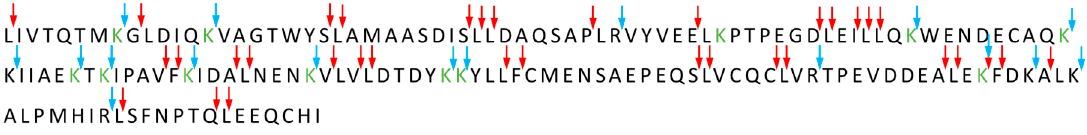
Figure 3. Predicted cleavage sites of pepsin at pH 1.3 (red arrows), mimicking gastric digestion, and trypsin (blue arrows), mimicking intestinal digestion. Cleavage sites were predicted using the amino acid sequence of β -lactoglobulin A as input in ExPASy, using the tool PeptideCutter [172]. Lysine (K) residues indicated in green have previously been identified to be subject to lactosylation [75,76].